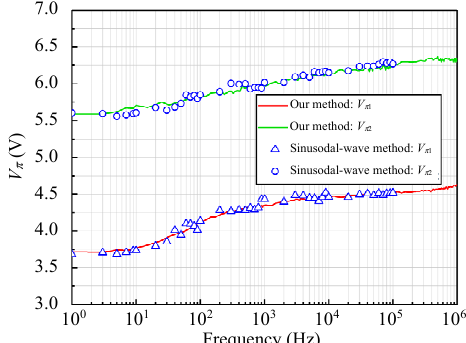
Fig. 5 Measured half-wave voltages with our method and the sinusoidal-wave